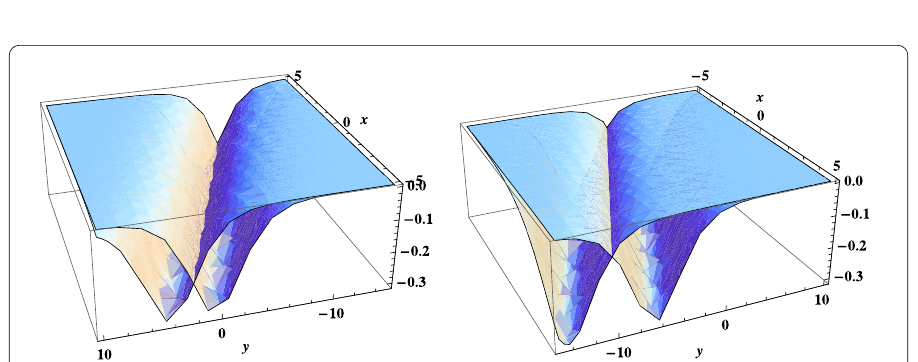
Figure 4 3D soliton solution of W ( x , y , t ) given in (3.8) when σ = 2 and respectively t = 1 and t = 2. The other assigned values are a = b = d = 1, k = e , γ = 1 2